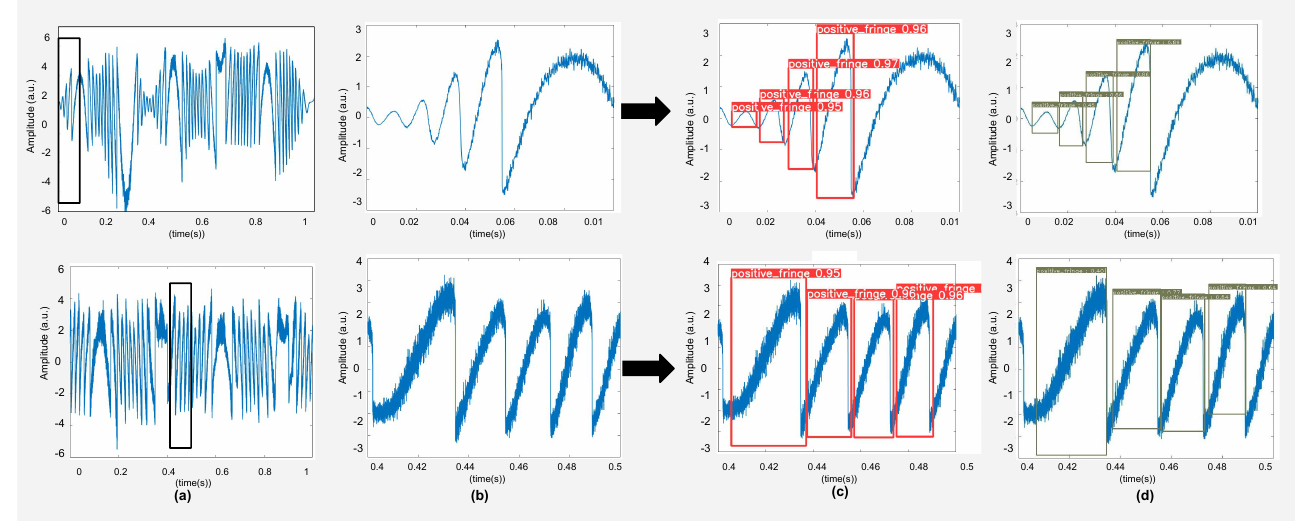
Figure 11. Results of testing of simulated SMI signals are shown on trained DNN models. ( a ) shows variable C -based simulated SMI signals under similar conditions of training, ( b ) shows an enlarged view of a segment of this SMI signal, and ( c , d ) show the results obtained by YOLOv5, and EfficientDet,